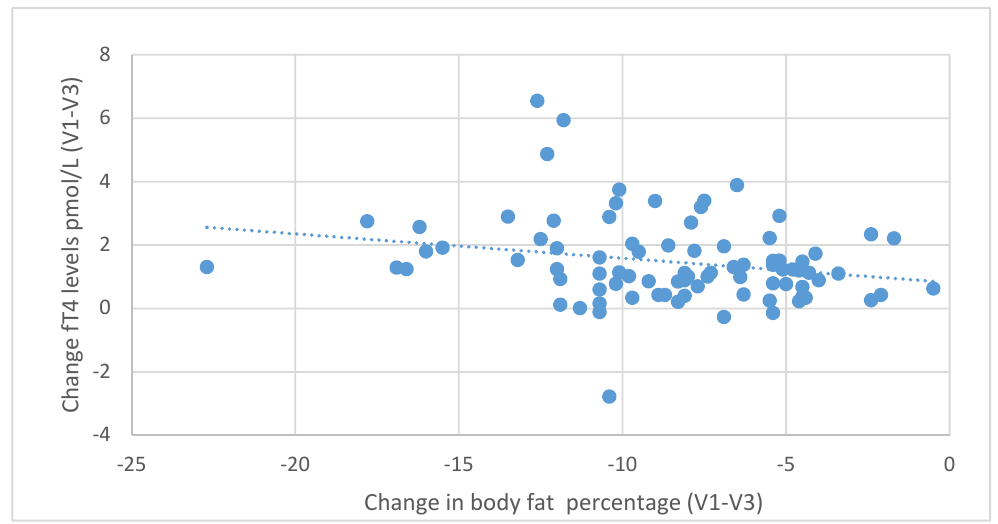
Figure 10. Correlations between differences in body fat content and changes in serum fT4 levels (between initial visit V1 and final visit V3).